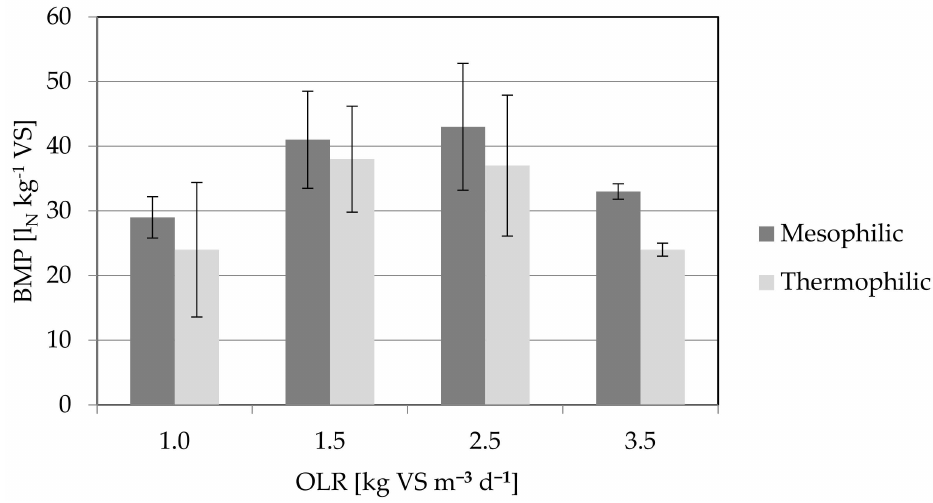
Figure 3. BMP of the residuals of the